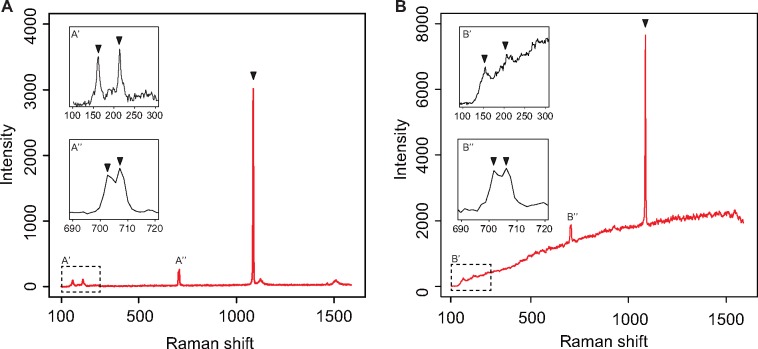
—Raman spectra of the shell and dart of Euhadra quaesita. Peaks at 154,205 cm−1 (lattice vibration), 702,706 cm−1 (in-plane bending), and 1,085 cm−1 (CO3 symmetric stretching) for shell (A) and the peaks at 153, 209, 702, 706, and 1,085 cm−1 for dart (B) are attributed to the Raman shifts specific to aragonite. Enlargements of these peaks are shown in the insets.